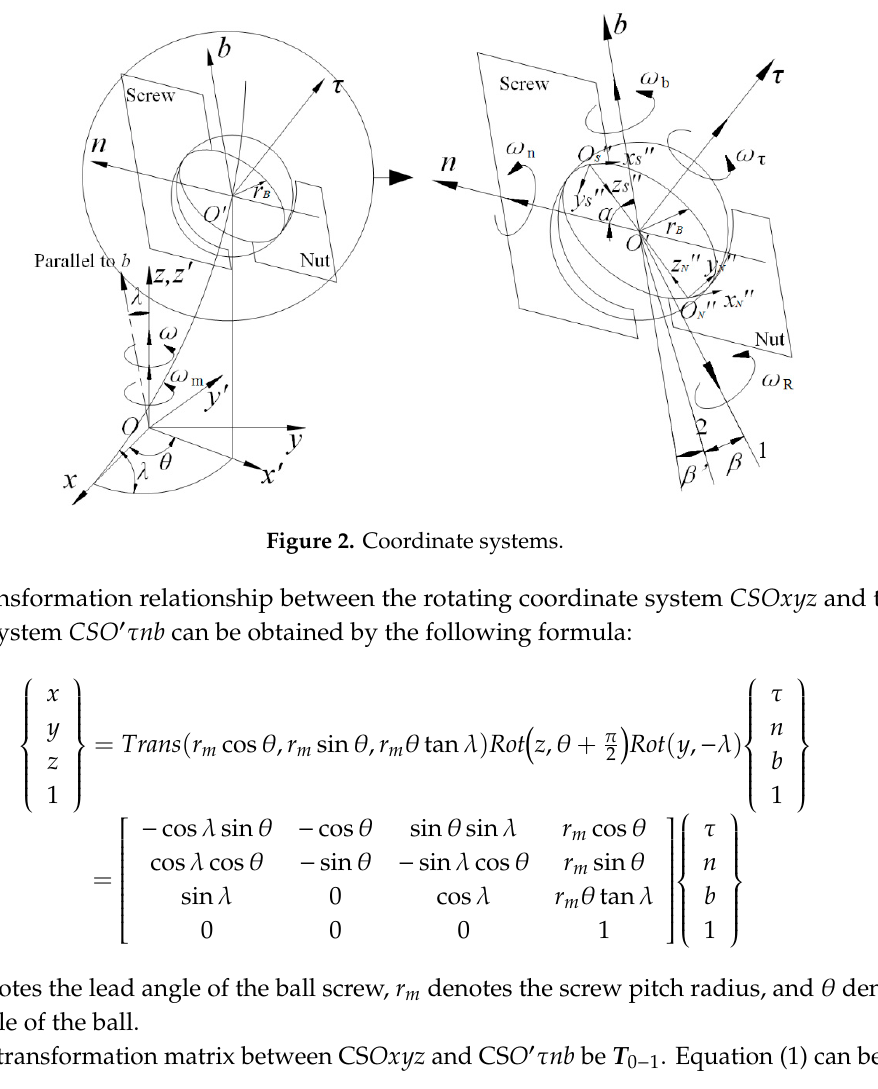
Figure 1. Rotating and local coordinate systems.